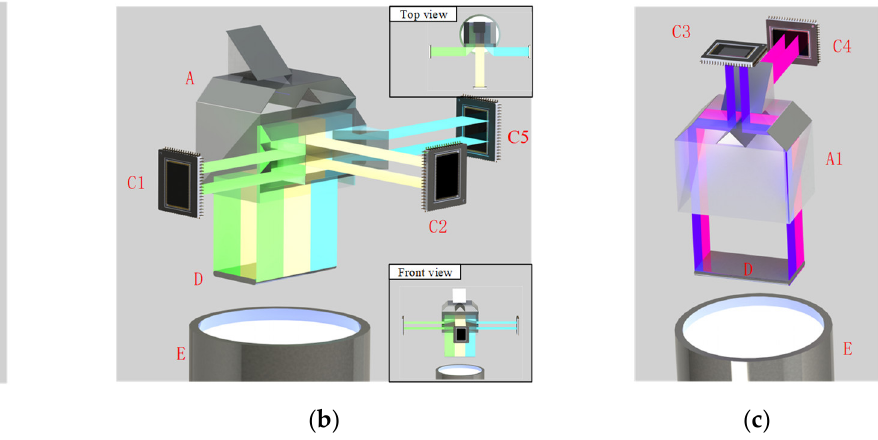
Figure 5. Schematic diagram of spatial distribution of imaging system and detail diagram of prism light path. ( a ) Spatial distribution of imaging system. ( b ) C1, C2 and C5 light path. ( c ) C3, C4 light path. (A) Prism assembly; (A1) part of prism assembly A; (B) camera lens; (C1–C5) cameras; (D) work piece to be measured; (E) parallel light source.